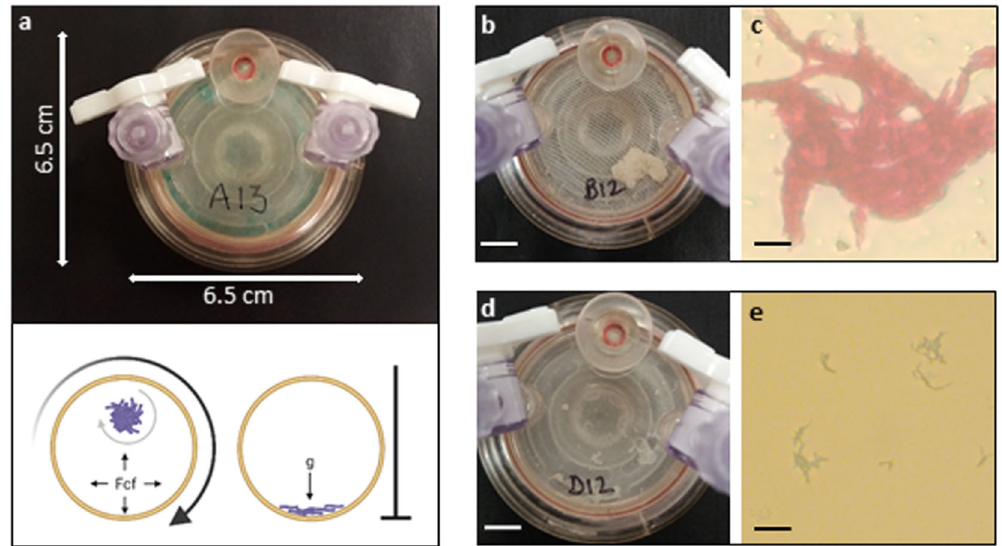
Fig. 1 Three-dimensional low shear Rotary Cell Culture System (RCCS) generates a mycobacterial bio fi lm phenotype. a The RCCS disposable vessel with entry ports to the front and gas permeable membrane and rotation fi xing to rear. Centrifugal force (Fcf) is controlled through rotation speed enabling biomass to grow without encountering the vessel walls. Gravity (g) in non-rotating controls collects biomass to the bottom of the vessel. b M. bovis BCG RCCS-bio fi lm formed after 21 days. c Heavily corded Kinyoun-stained RCCS-bio fi lm after 21 days. d Biomass in non-rotating control at the bottom of the vessel after 21 days (vessel agitated for imaging). e Kinyoun-stained non-rotating control with limited cording after 21 days. White scale bar is 1 cm, black scale bar is 20